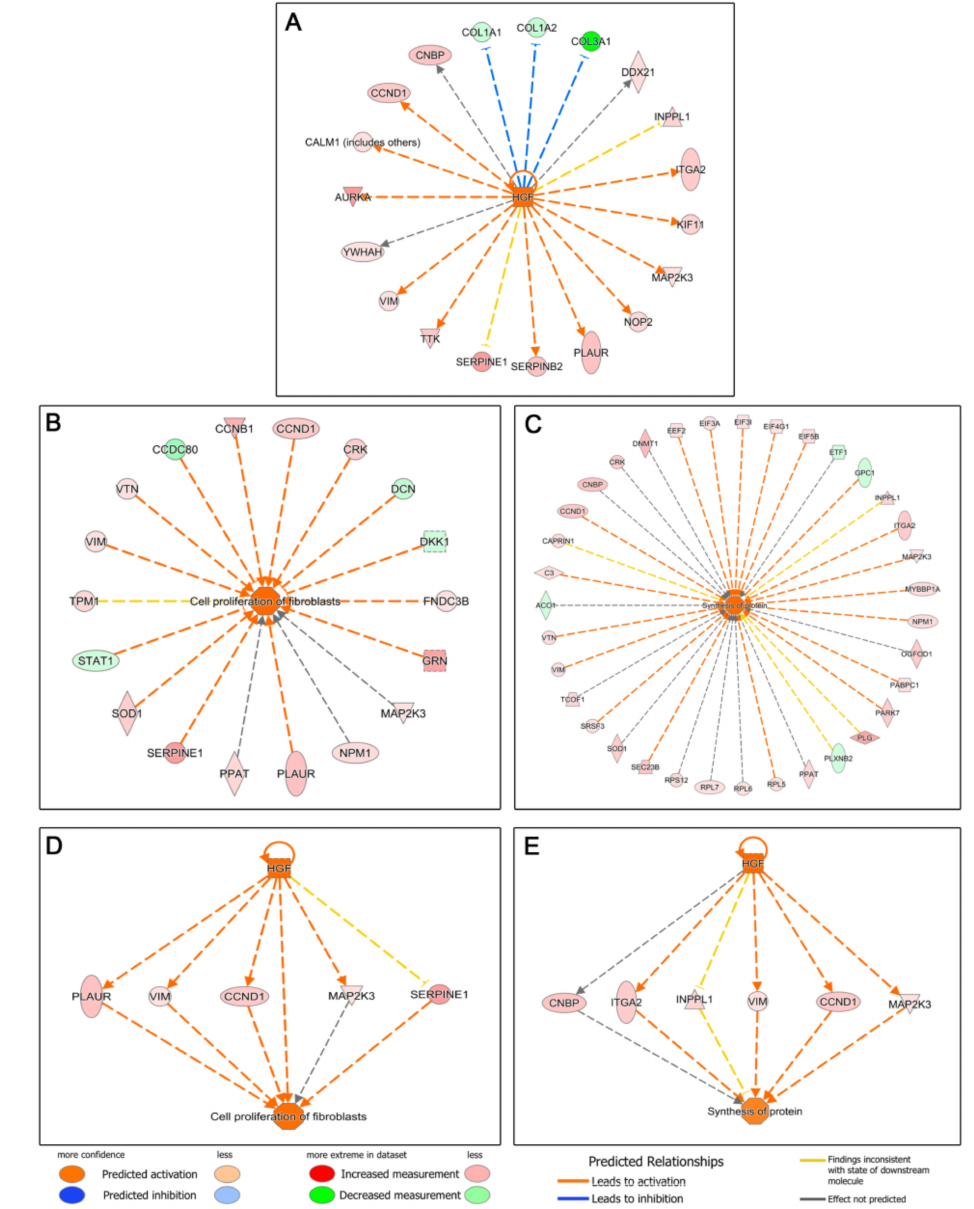
Figure 3. Ingenuity Pathway Analysis (IPA) of deregulated proteins related to hepatocyte growth factor (HGF) signaling in human dermal fibroblasts (HDFs) treated with Endoret serum (ES) extract. ( A ) The IPA upstream regulator analysis suggested that several HDF proteins deregulated in the ES treatment were related to the activation by HGF. IPA downstream analysis also showed that numerous deregulated proteins were associated with an induction of ( B ) fibroblast proliferation and ( C ) protein synthesis of HDFs treated with ES. Finally, when the upstream and downstream processes were correlated, certain relationships were observed for ES-treated HDFs, such as HGF with an induction of ( D ) fibroblast proliferation and ( E ) protein